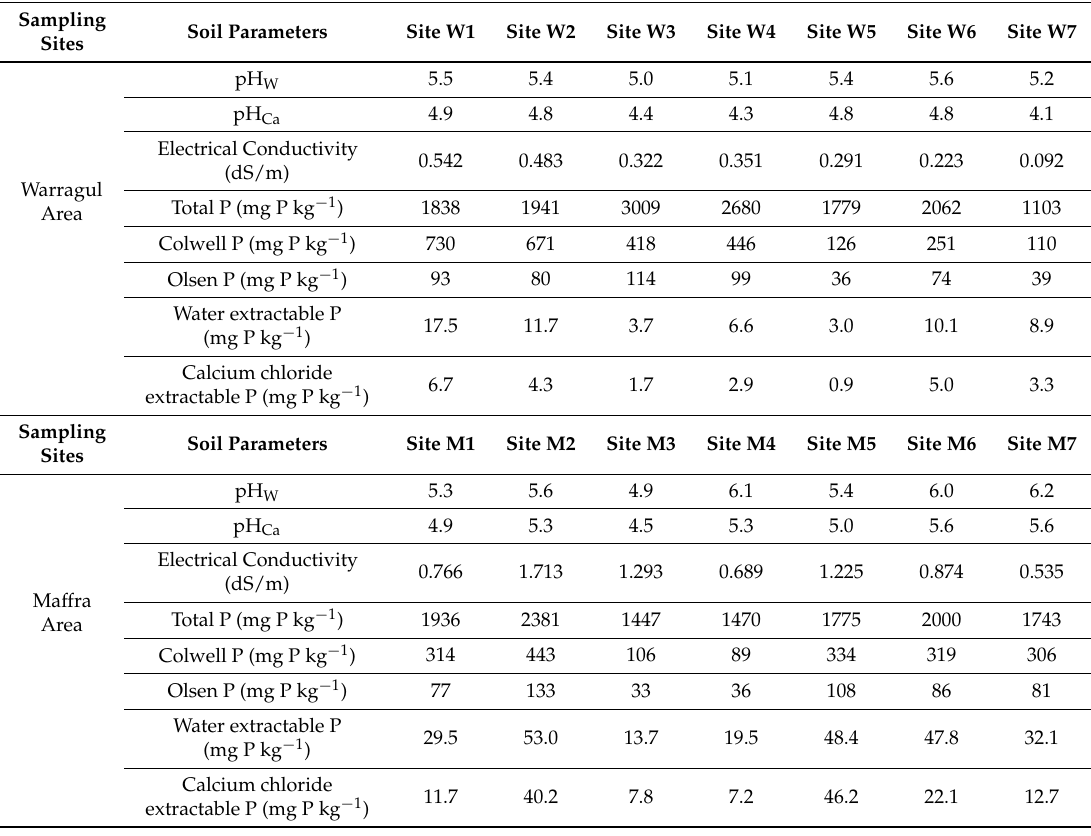
Warragul and Maffra areas.